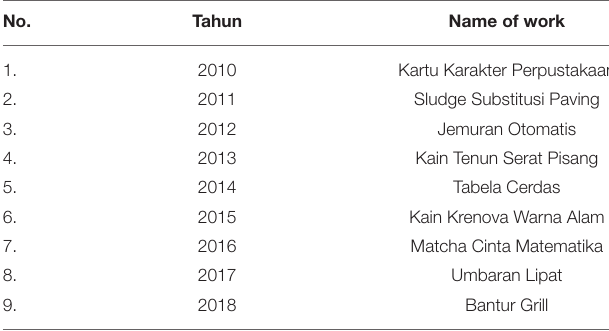
TABLE 4 | Works that won the provincial innovation